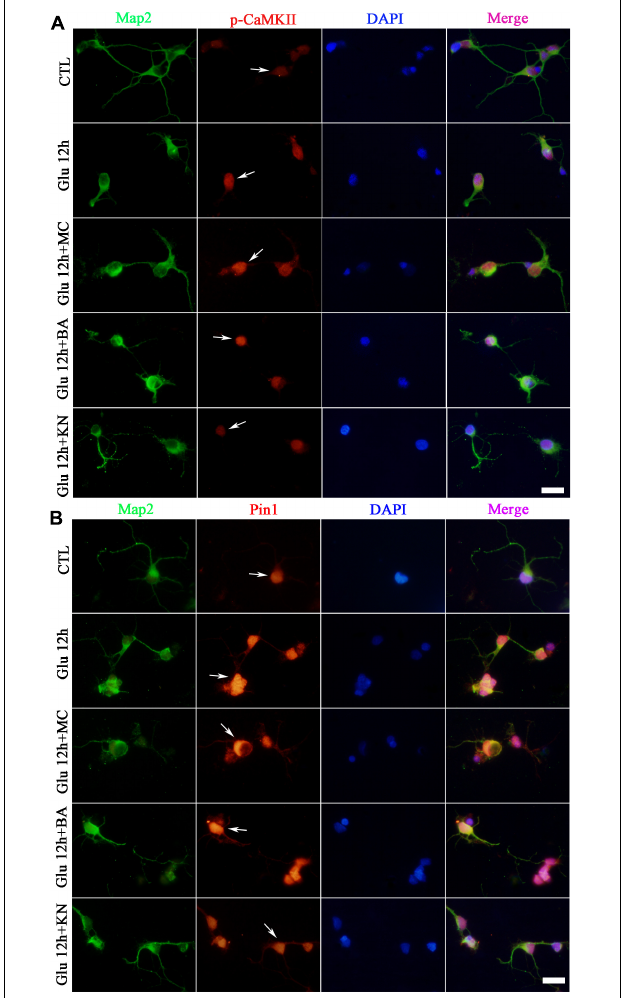
FIGURE 6 | Immunofluorescence staining of p-CaMKII and Pin1 after glutamate and drugs treatment. (A) Immunofluorescence staining of p-CaMKII (red) and Map2 (green). (B) Immunofluorescence staining of Pin1 (red) and Map2 (green). N = 3 cultures. MC, BA, and KN were used 30 min before 12 h glutamate treatment at a concentration of 50, 10, and 10 µ M, respectively. Scale bar = 10 µ m in all